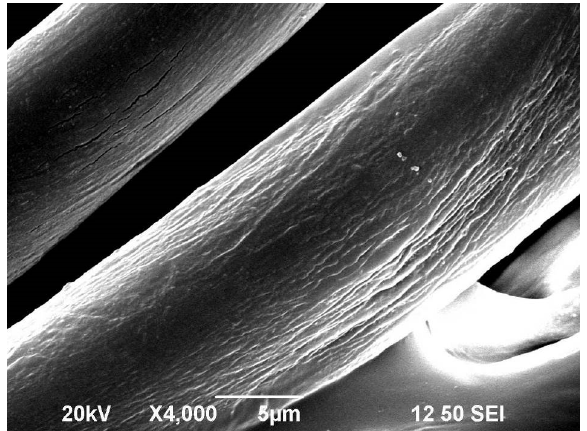
Figure 4. SEM image of plasma treated cotton after pigment dyeing (condition: (discharge power = 170 W; oxygen flow rate = 0.4 L/min; jet moving speed = 5 mm/s and jet to substrate distance = 3 mm).